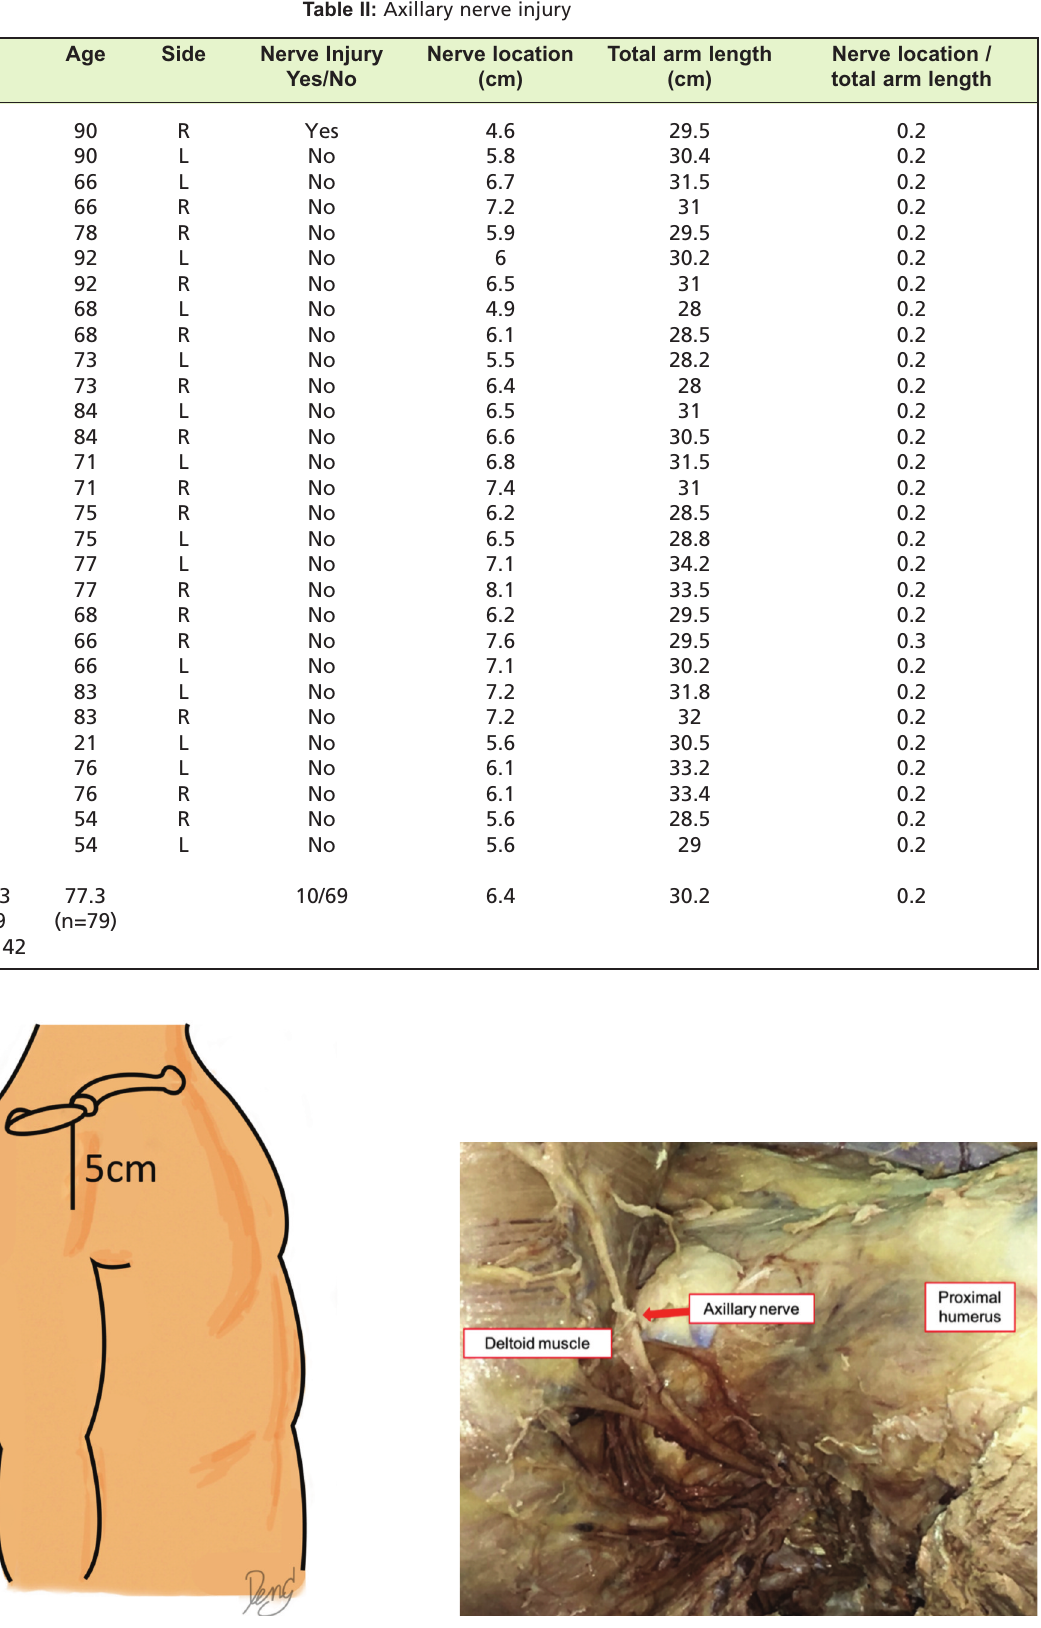
Deltoid muscle reflected and the Axillary nerve Fig. 2: